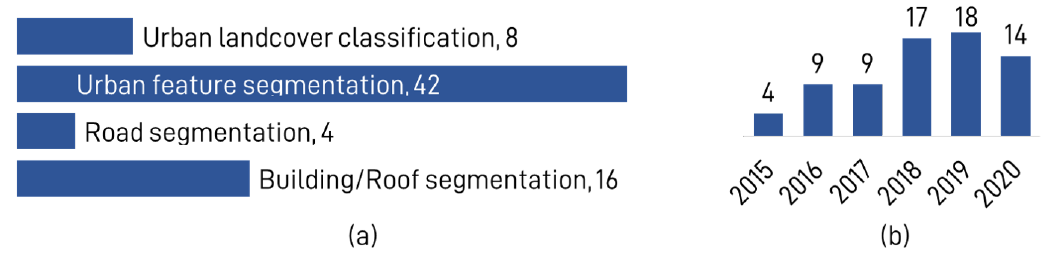
Figure 2. Evolution of deep learning-based semantic segmentation of urban remote sensing images. ( a ) The distribution of number of publications into four study targets. ( b ) The number of publications by year. Table 1. Overview of the research problems the papers were motivated to solve in order to improve the results of semantic